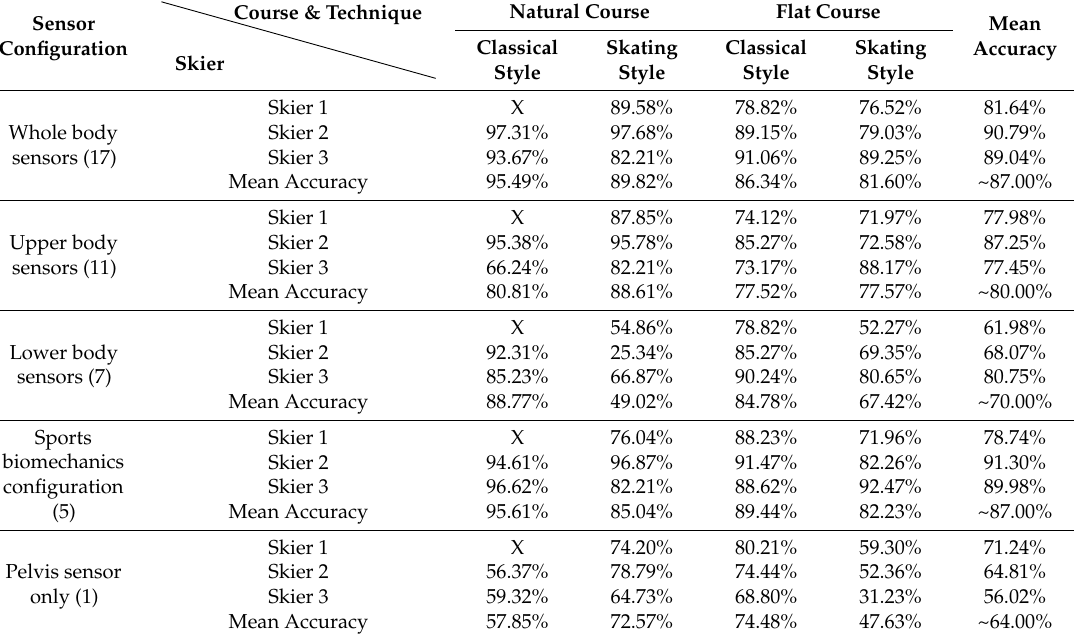
Table 10. Classification accuracies for the validation dataset for five different sensor configurations.